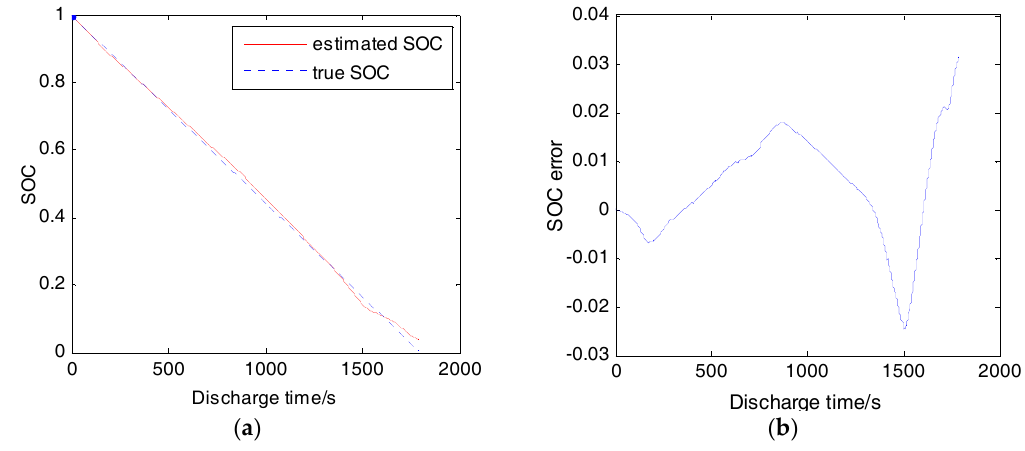
Figure 13. SOC estimation result (25 °C, 2 C, resistance correction): ( a ) Estimated SOC and true SOC; ( b ) SOC estimation error. Table 2. Correction coefficient at the calibrated temperatures.